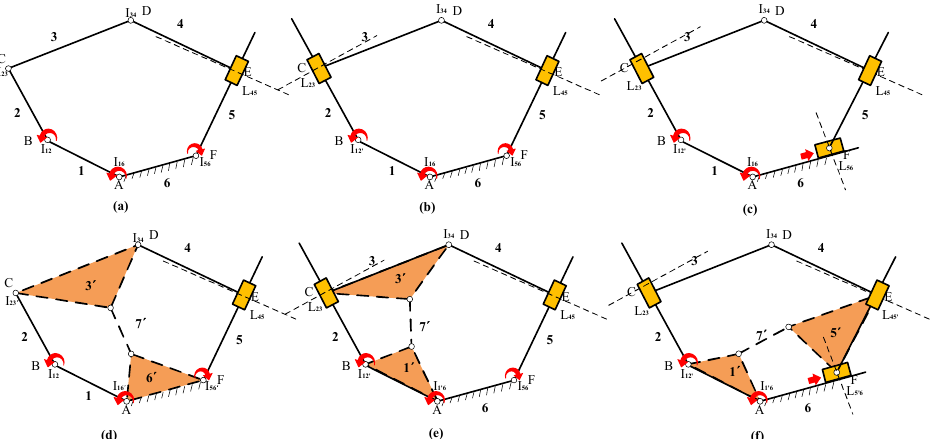
Figure 16. Single-loop six-bar planar linkage with ( a ) one prismatic joint, ( b ) two prismatic joints, ( c ) three prismatic joints, ( d ) one prismatic joint and virtual links 3’, 6’, 7’, ( e ) two prismatic joints and virtual links 1’, 3’, 7’, ( f ) three prismatic joints and virtual links 1’, 5’, 7’.